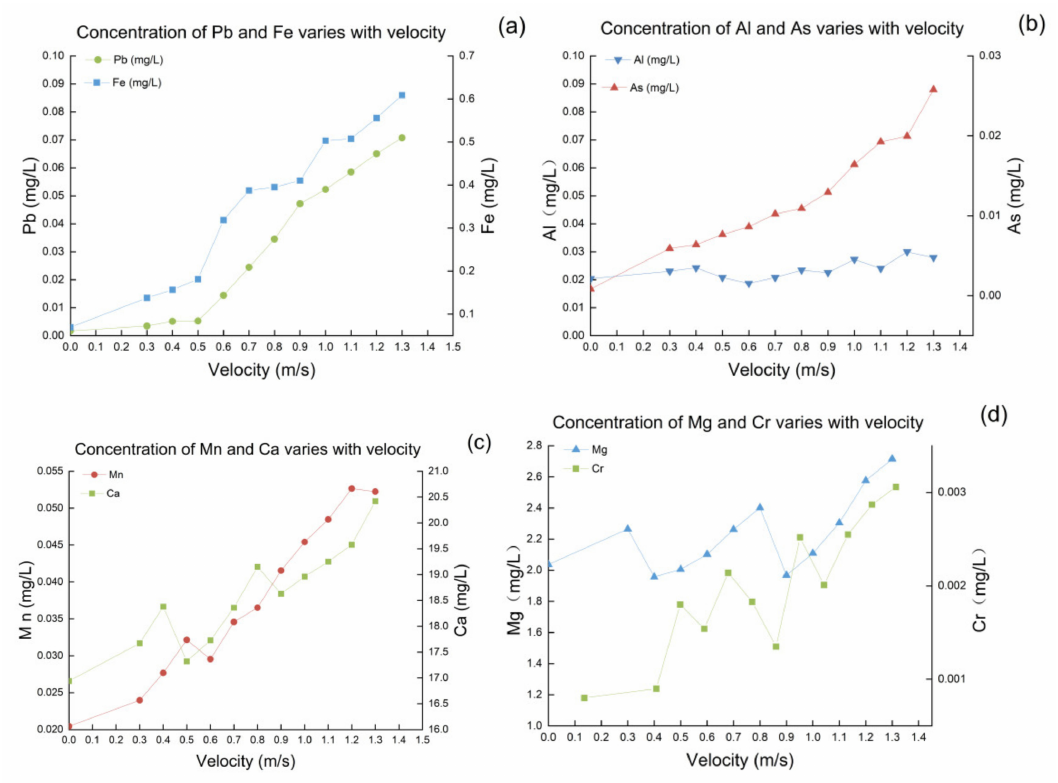
Figure 14. Effects of suspended particulate matter at different velocity adsorption and release in DN25 tube of Pb and Fe ( a ); Al and As ( b ); Mn and Ca ( c ), Mg and Cr ( d